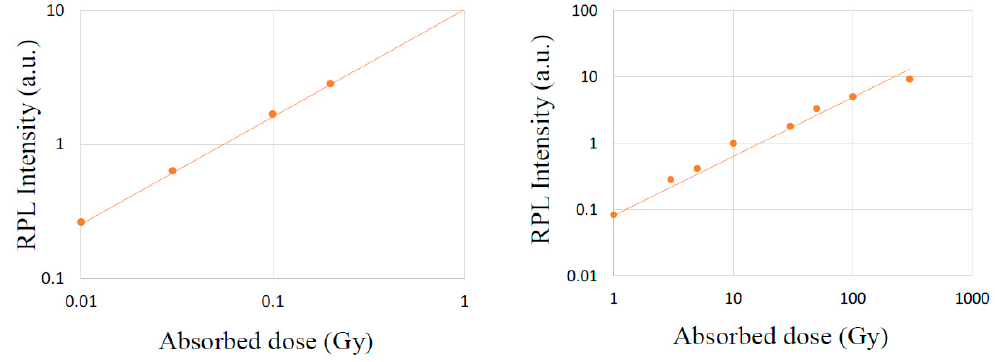
Figure 6. RPL intensity of sheet-type glass dosimeter as a function of gamma-rays absorbed dose in the range from 0.01 [Gy] to 300 [Gy].